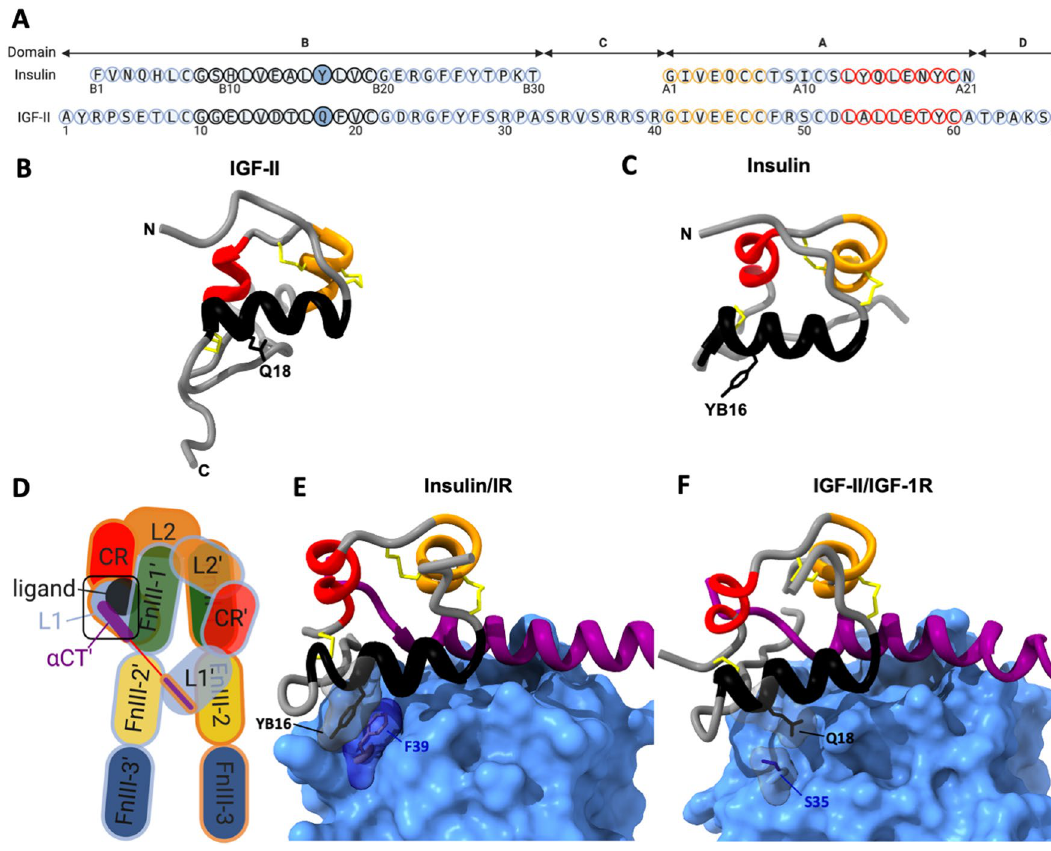
Figure 1. Sequence and structural comparison of IGF-II and insulin. ( A ) Sequence alignment of IGF-II and insulin. Domains are indicated above. Each peptide has three alpha helices; B-chain helix 1 (black circles), A-chain helix 2 (orange circles) and A-chain helix 3 (red circles). Residue numbers are indicated below each sequence. Insulin YB16 and IGF-II Q18 residues are in solid filled circles. ( B ) IGF-II and ( C ) insulin ribbon structures (PDB: 1IGL and 1MSO respectively) show the three disulphide bonds and helices coloured as in ( A ). Side chains of YB16 in insulin and Q18 in IGF-II are shown. ( D ) Schematic diagram representing the IR and IGF-1R ligand bound extracellular domain structures. Individual αβ monomer outlines are coloured either blue or orange. Extracellular domains include the first and second leucine-rich repeat domains (L1 and L2), cysteine- rich domain (CR), first, second and third fibronectin type-III domains (FnIII-1, -2, and -3), insert domain (ID), α-chain C-terminal region (αCT). Transmembrane and intracellular domains, including the tyrosine kinase domain, are not shown. ( E ) Insulin and ( F ) IGF-II bound to site 1 of their cognate receptors, as highlighted with the black box in ( D ) (from PDB: 6HN5 and 6VWI, respectively). L1 domains are surface filled in cornflower blue, α-chain C-terminal regions (αCT) are coloured purple. The side chains of insulin residue YB16 and F39 of the IR L1 domain and the equivalent residues Q18 in IGF-II and S35 of the IGF-1R L1 domain are shown with transparent surface